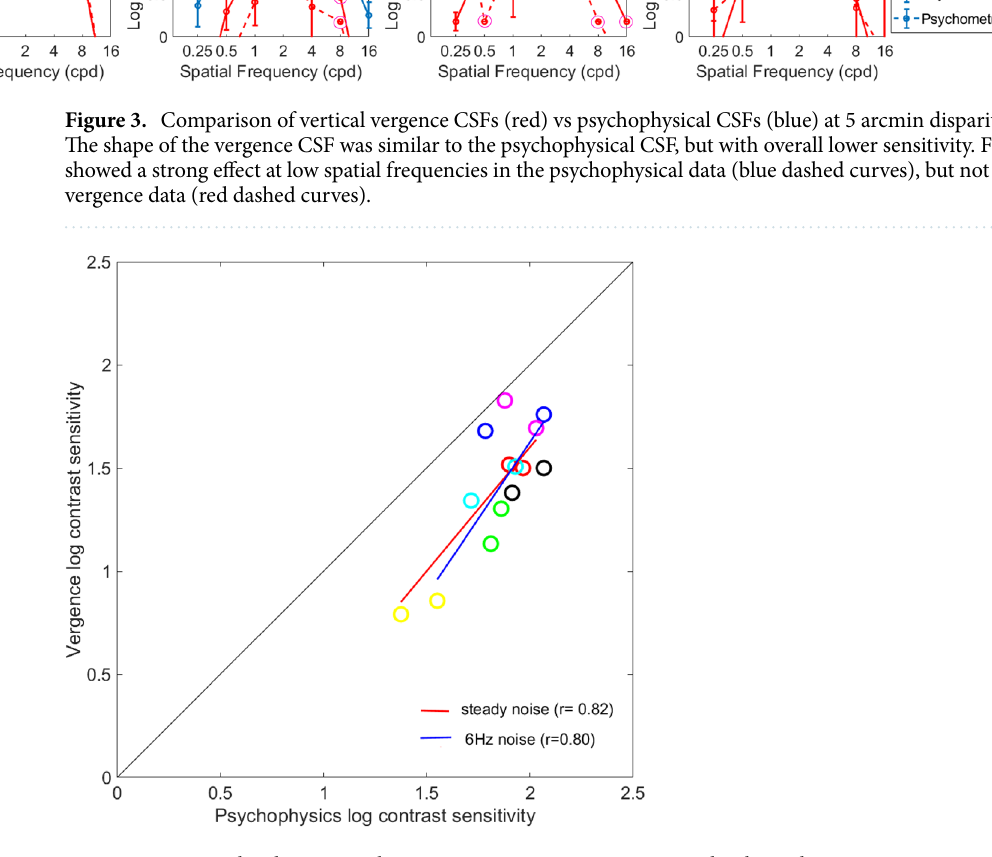
trast sensitivity and vertical vergence contrast sensitivity for both steady noise (r = 0.82) and 6 Hz noise(r = 0.80) data. Most subjects show a similar change on both measures when going from steady to flicker. The contrast sensitivity of vertical vergence is therefore a reasonably good predictor of psychophysical contrast sensitivity at 2 cpd spatial frequency.